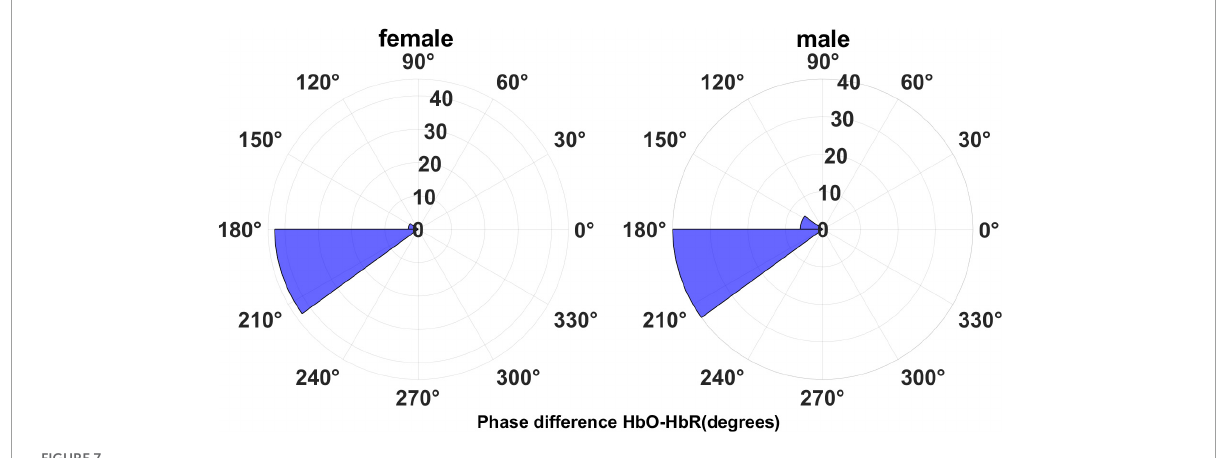
FIGURE7 The phase difference for HbO-HbR concentration data.